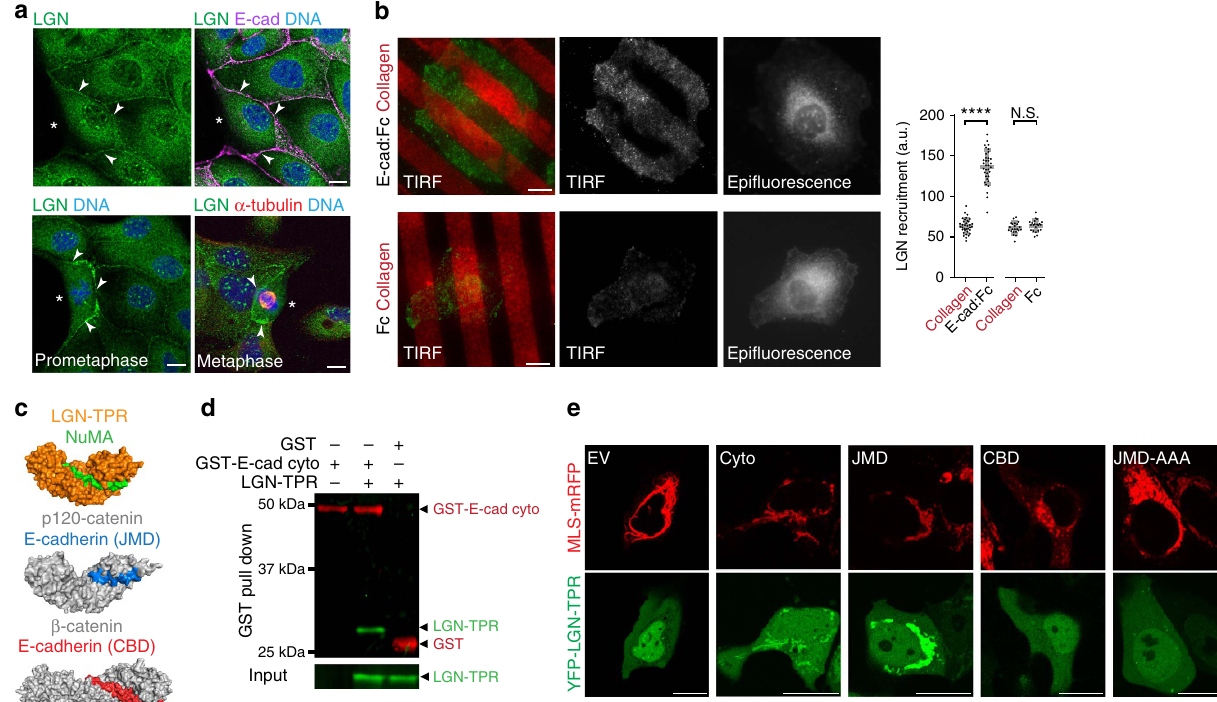
Figure 1 | LGN is recruited to cell–cell contacts directly by E-cadherin. ( a ) Localization of endogenous LGN at cell–cell contacts, marked with E-cadherin (E-cad), in interphase and mitotic MDCK cells. Arrowheads identify cell–cell contacts, and asterisks mark plasma membrane not contacting another cell. ( b ) TIRF and epifluorescence microscopy imaging of endogenous LGN in MDCK cells plated on surfaces micro-patterned with alternating stripes of collagen-IV/E-cad:Fc or collagen-IV/Fc, with a quantification of LGN staining intensities at the plasma membrane bound to different stripes. Quantified data were pooled from three independent experiments, grey bars show mean ± s.d. ( c ) Surface structures of NuMA in complex with the TPR repeats of LGN 20 , and of b -catenin and p120-catenin with E-cadherin 32,33 . For more details of the E-cadherin/p120-catenin and LGN/NuMA-binding interface, see Supplementary Fig. 2. CBD, catenin binding domain; JMD, juxtamembrane domain. ( d ) GST-pull down of recombinant E-cadherin cytosolic tail (GST-E-cad-cyto) with LGN–TPR, immunoblotted for GST (red) and LGN (green). ( e ) U2OS cells, with low levels of endogenous E-cadherin, showing recruitment of YFP-tagged LGN–TPR to E-cadherin cytosolic tail (cyto) or JMD targeted to mitochondria by fusion with the mitochondrial localization signal (MLS) of ActA. This recruitment was not observed with CBD or the JMD containing a DEE758-760AAA mutation. EV, empty vector. Scale bars, 10 m m; **** P o 0.0001; N.S ¼ not significant, using paired student t